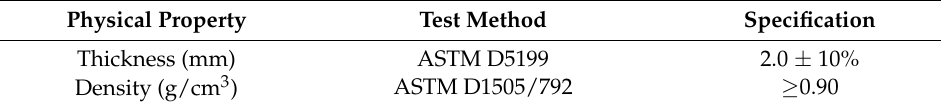
Table 2. Material specification of H.D.P.E impermeable cloth in Section